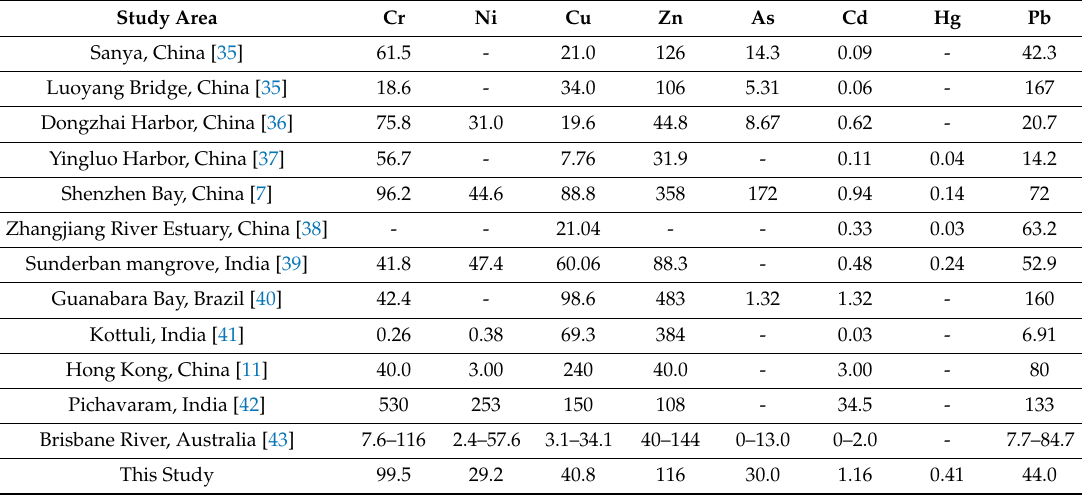
Table 8. Levels of heavy metals in mangrove wetland